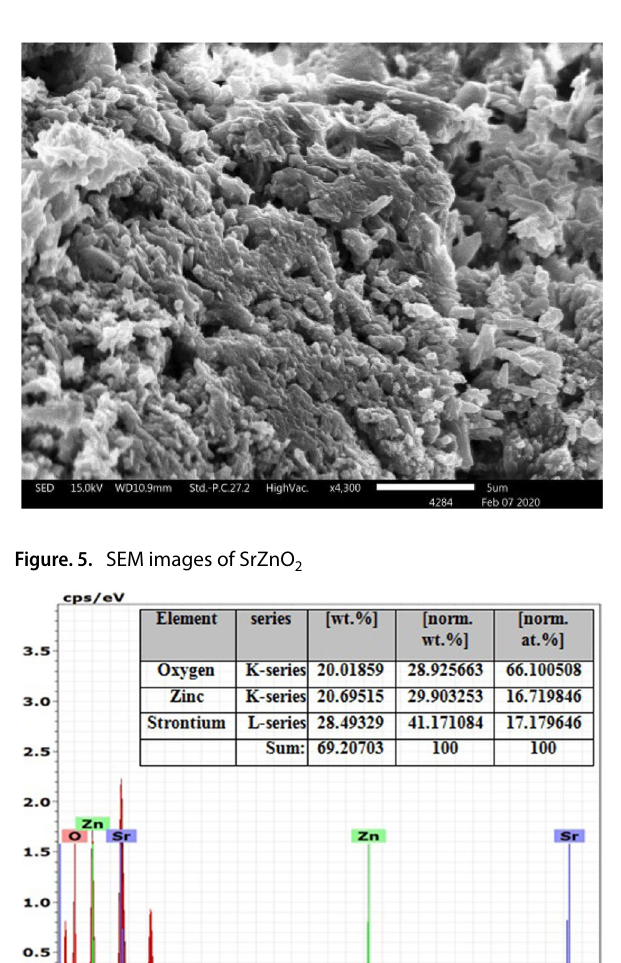
Fig. 6 EDAX results of SrZnO